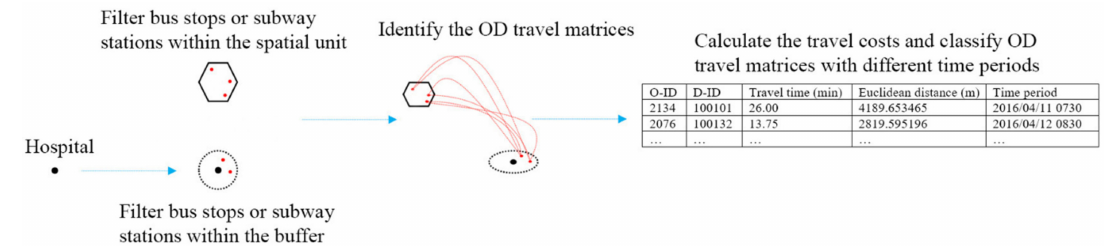
Figure 4. The schematic diagram of the derived origin and destination matrix (where OD = origin–destination, O–ID = origin identifier, D–ID = destination identifier).